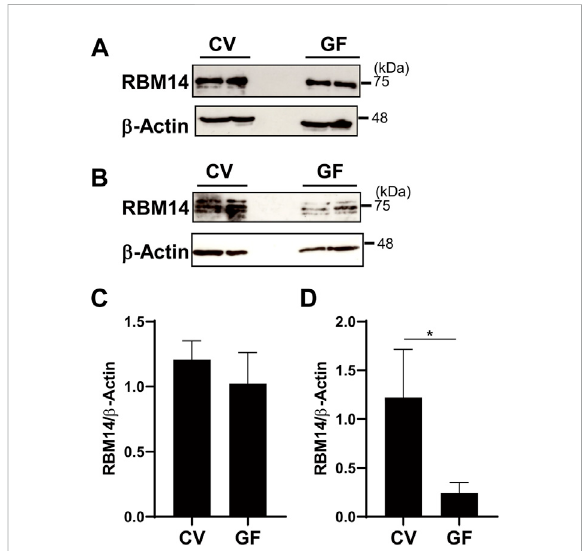
FIGURE 6 Expression of RBM14 is induced by gut microbiota in colonic epithelial cells. Expression of RBM14 in epithelial cells from medial small intestine (A and C) and colon (B and D) of CV and GF mice wasanalyzedbywesternblotting.Representativeblots (A and B) and mean ± SD of relative band intensities normalized to those of β -actin (C and D) of four independent experiments are shown. The band intensities was measured as total of all three bands because triplet bands did not always separate clearly. IECs pooled from 3-6 mice were used for each experiment. * Signi fi cantly different ( p <